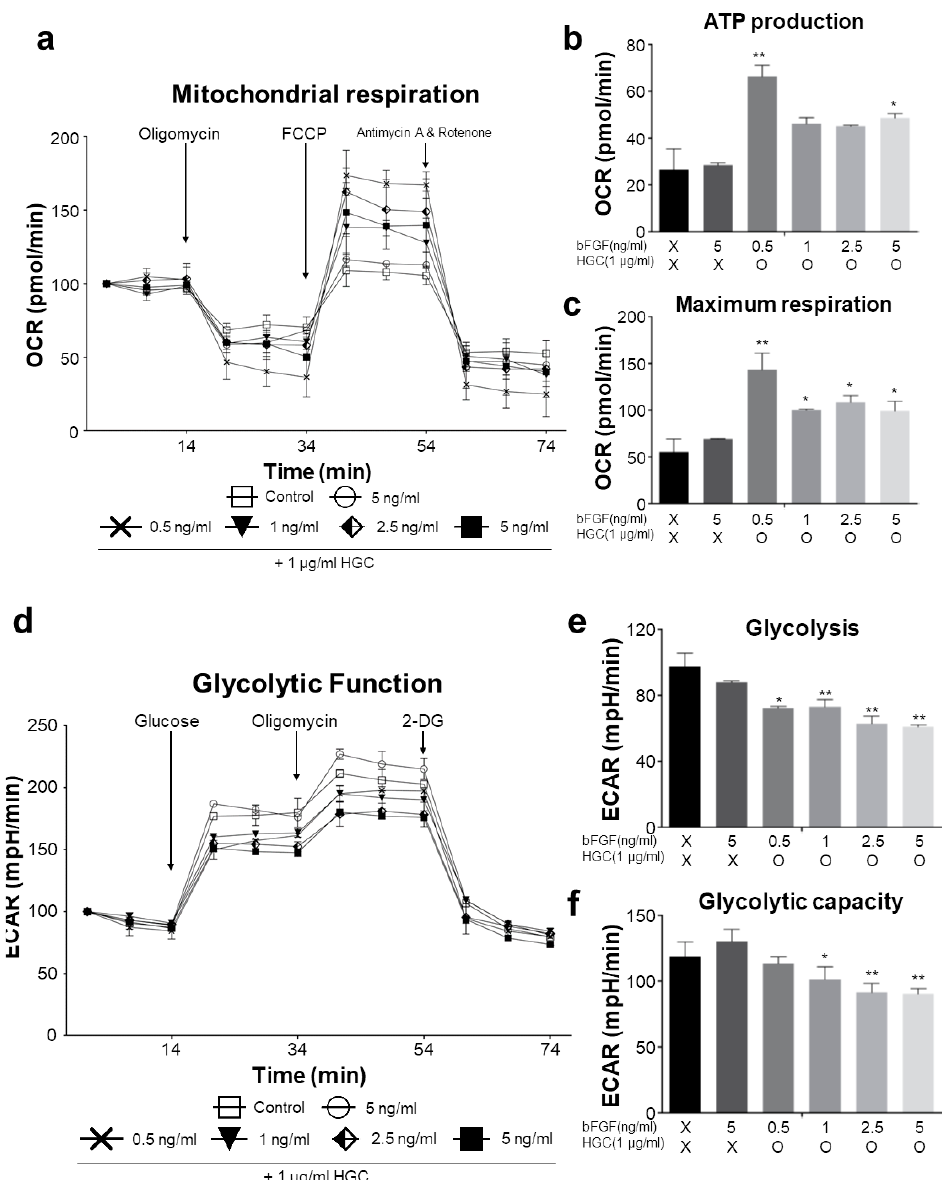
Figure 5. The analysis of metabolic functionality of AD-MSCs at passage 10. ( a ) The measurement of oxygen consumption rate following oligomycin, FCCP, antimycin A, and rotenone treatment; ( b ) ATP production; ( c ) maximum respiration; ( d ) The measurement of extracellular glycolytic acidification following glucose, oligomycin, and 2-DG treatment. Glycolytic function displayed an increased extracellular acidification rate in control and 5 ng/mL bFGF-only treated group; ( e ) glycolysis and ( f ) glycolytic capacity. * p < 0.05 and ** p < 0.01 relative to the control. FCCP: carbonyl cyanide-4 (trifluoromethoxy) phenylhydrazone, 2-DG: 2-deoxy-glucose.